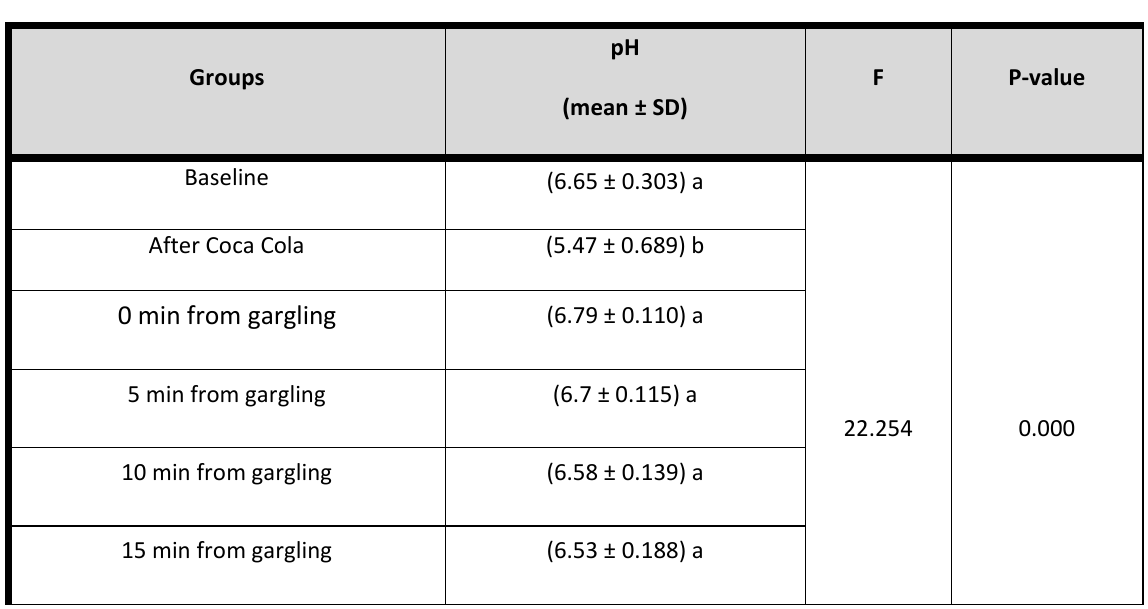
a: homogenous group, b and c: significant differences at p ≤ 0.05.